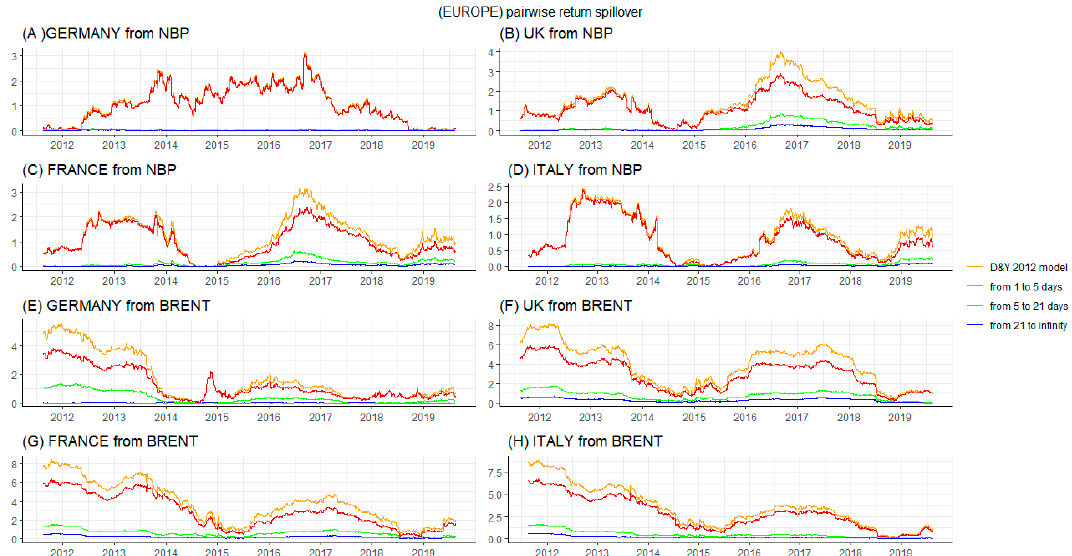
Figure A2. Pairwise directional return spillover of DY12 and BK18 in Europe. Notes: GERMANY from NBP indicates the return spillover from natural gas to Germany; UK from NBP indicates the return spillover from natural gas to the UK; FRANCE from NBP indicates the return spillover from natural gas to France; ITALY from NBP indicates the return spillover from natural gas to Italy; GERMANY from BRENT indicates the return spillover from crude oil to Germany; UK from BRENT indicates the return spillover from crude oil to the UK; FRANCE from BRENT indicates the return spillover from crude oil to France; ITALY from BRENT indicates the return spillover from crude oil to Italy.